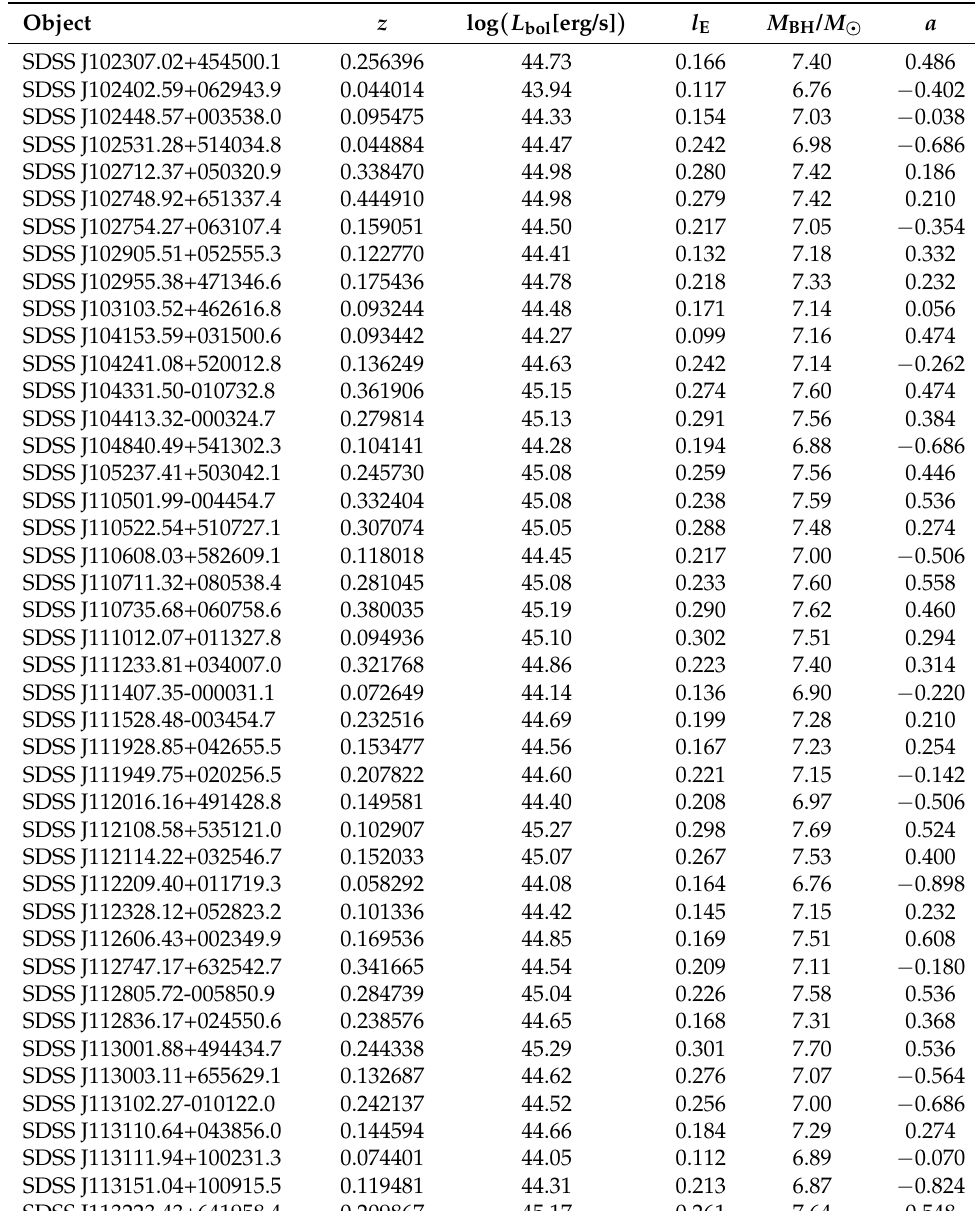
Table A4. All objects with their estimated spin values. Part 4 of